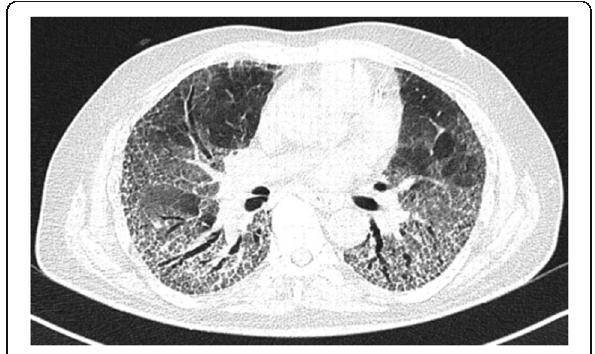
Fig. 2 CT scan lung window showing honeycombing with traction